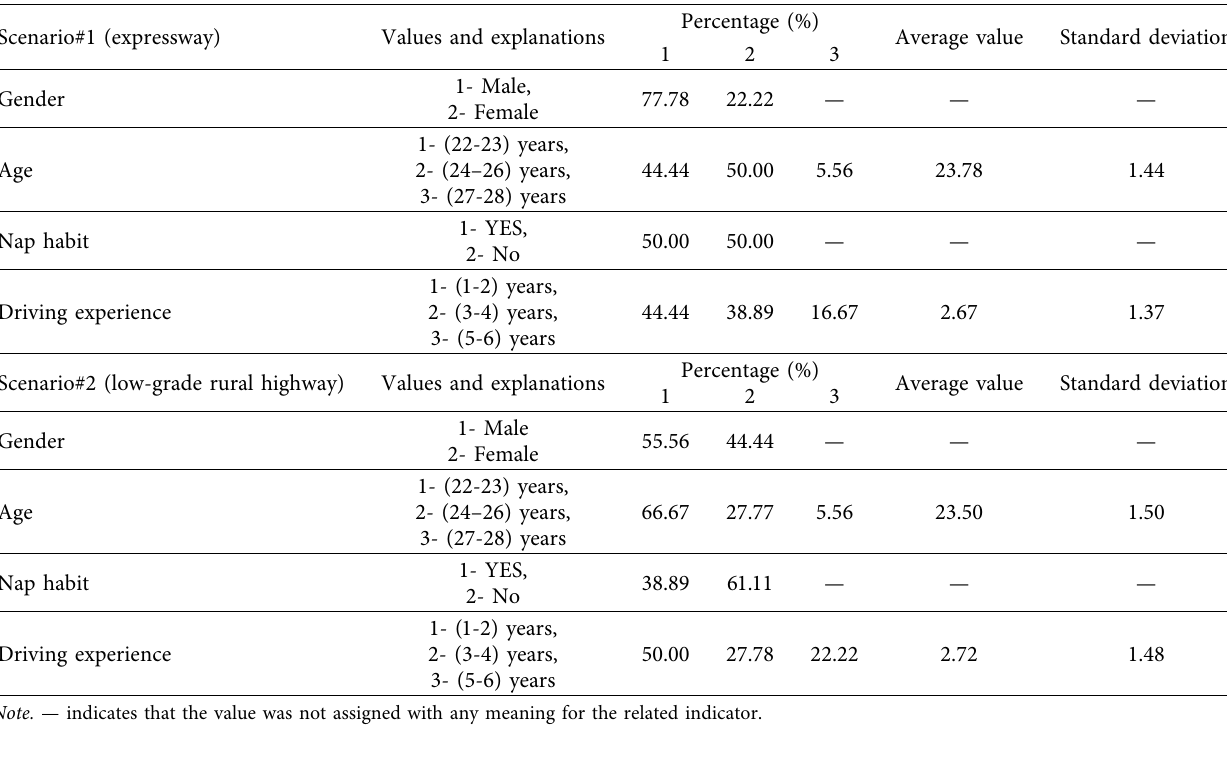
Table 2: Driving factor variable.